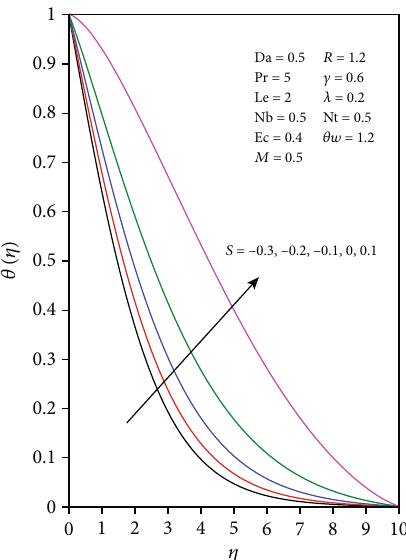
Figure 6: Temperature pro fi le for di ff erent values of S . Figure 4: Temperature pro fi le for di ff erent values of R